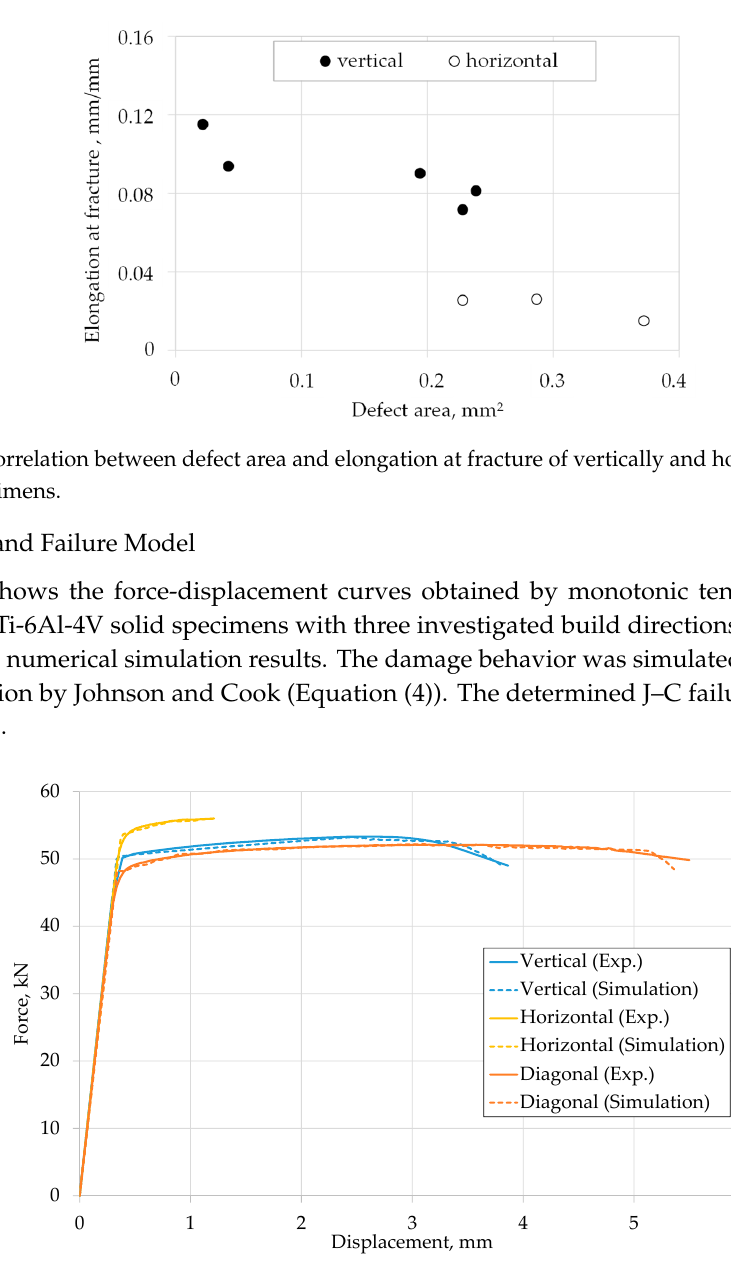
Figure 7. Comparison of force-displacement curves from experiments and numerical simulations. Table 5. J–C failure parameters identified on tensile tests for different build directions.